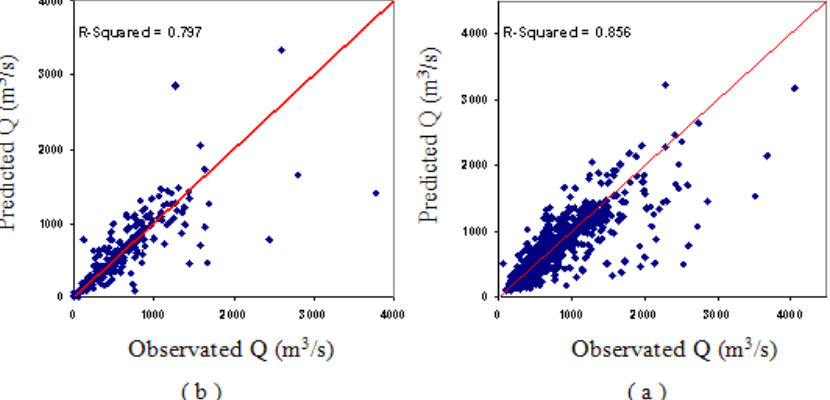
Fig. 3 Observed discharge versus predicted discharge for model 1: a) training data, b) testing